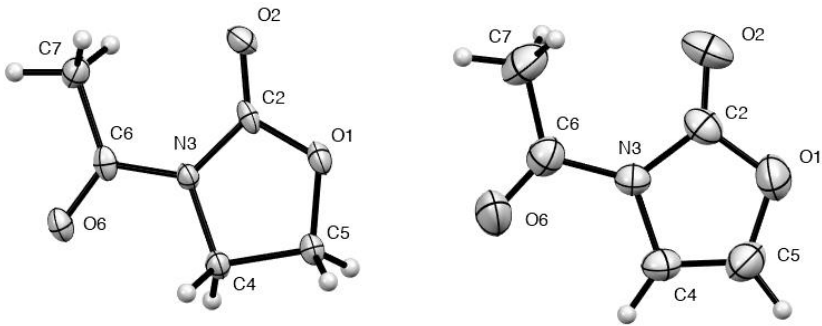
Figure 1. Structures of compounds 1 and 3 (thermal ellipsoids at 50% probability). Table 1. Bond lengths and angles for 1 and 3.